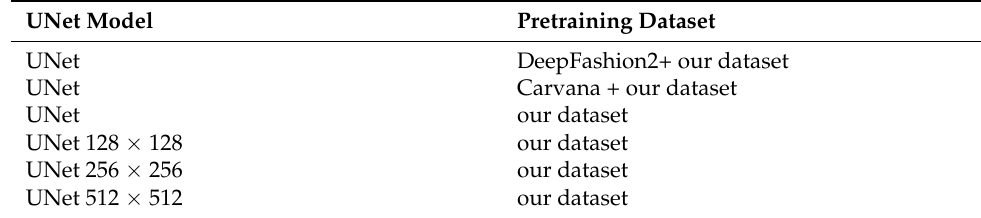
Table 1. UNet models with different pre-trained